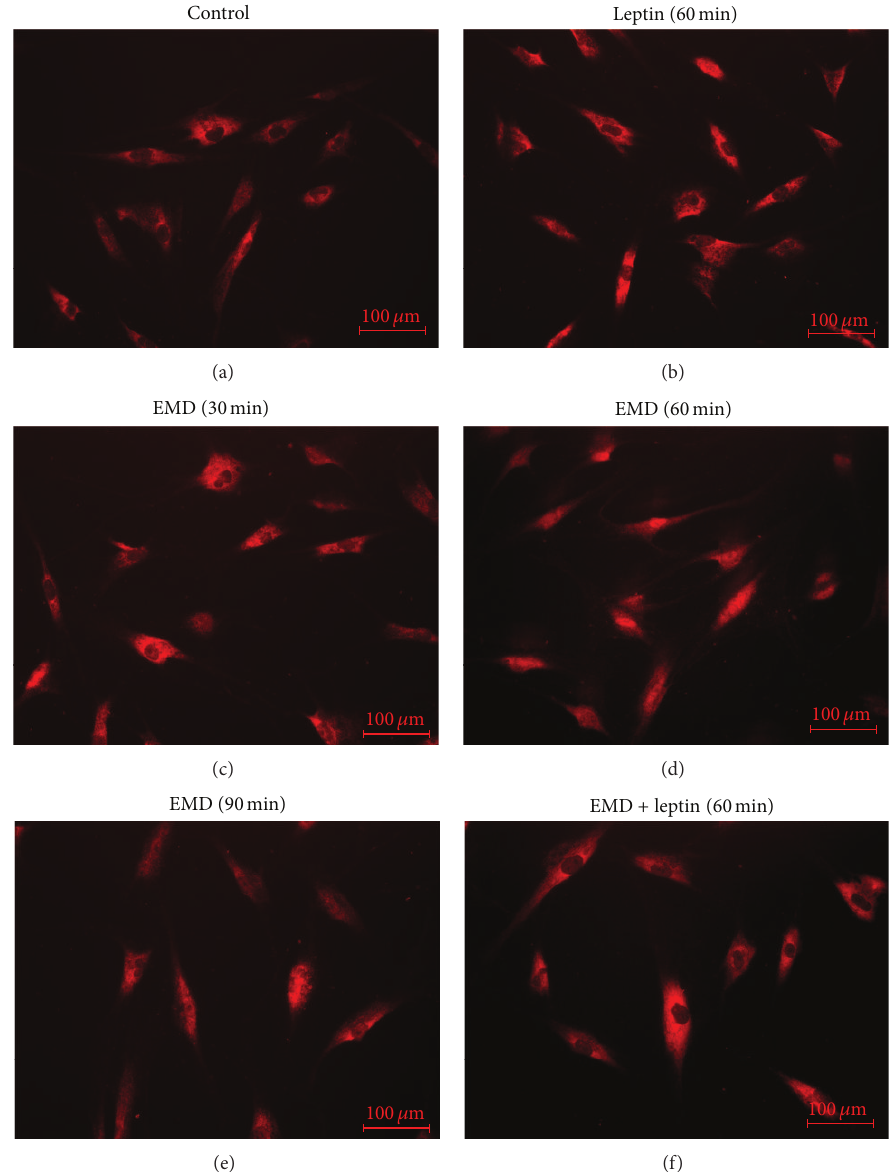
Figure 3: Effect of EMD on the nuclear translocation of SMAD1/5/8 in the presence and absence of leptin (3 ng/mL), as determined by immunofluorescence ((a)–(f)). Experiments were performed in triplicate and repeated twice. Untreated cells served as control. Images from one representative donor are